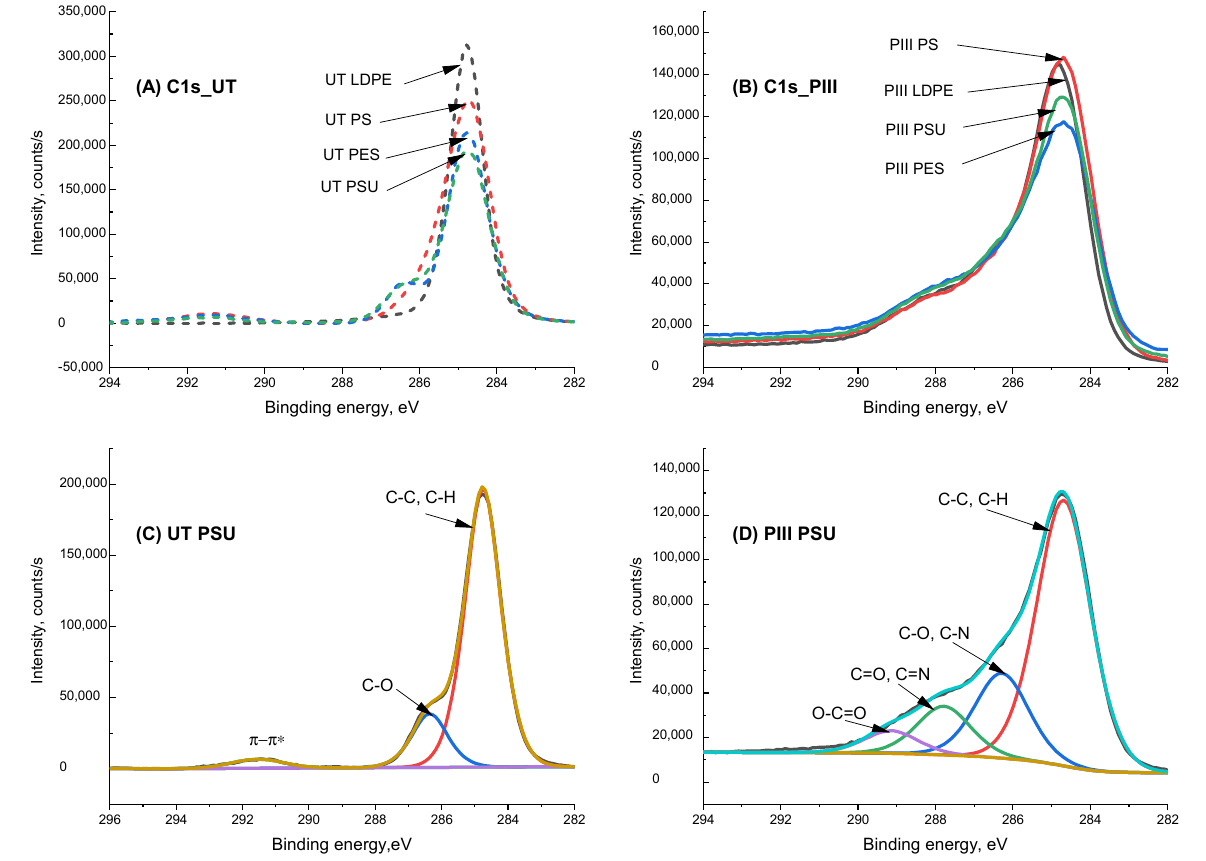
Figure 4. XPS C1s carbon peak. Comparison of the C1s peak of the 4 polymers before ( A ) and after the PIII treatment ( B ). Deconvoluted C1s peak of untreated PSU ( C ) and PIII-treated PSU ( D ). Dashed lines and solid lines represent untreated and PIII-treated polymer spectra, respectively.